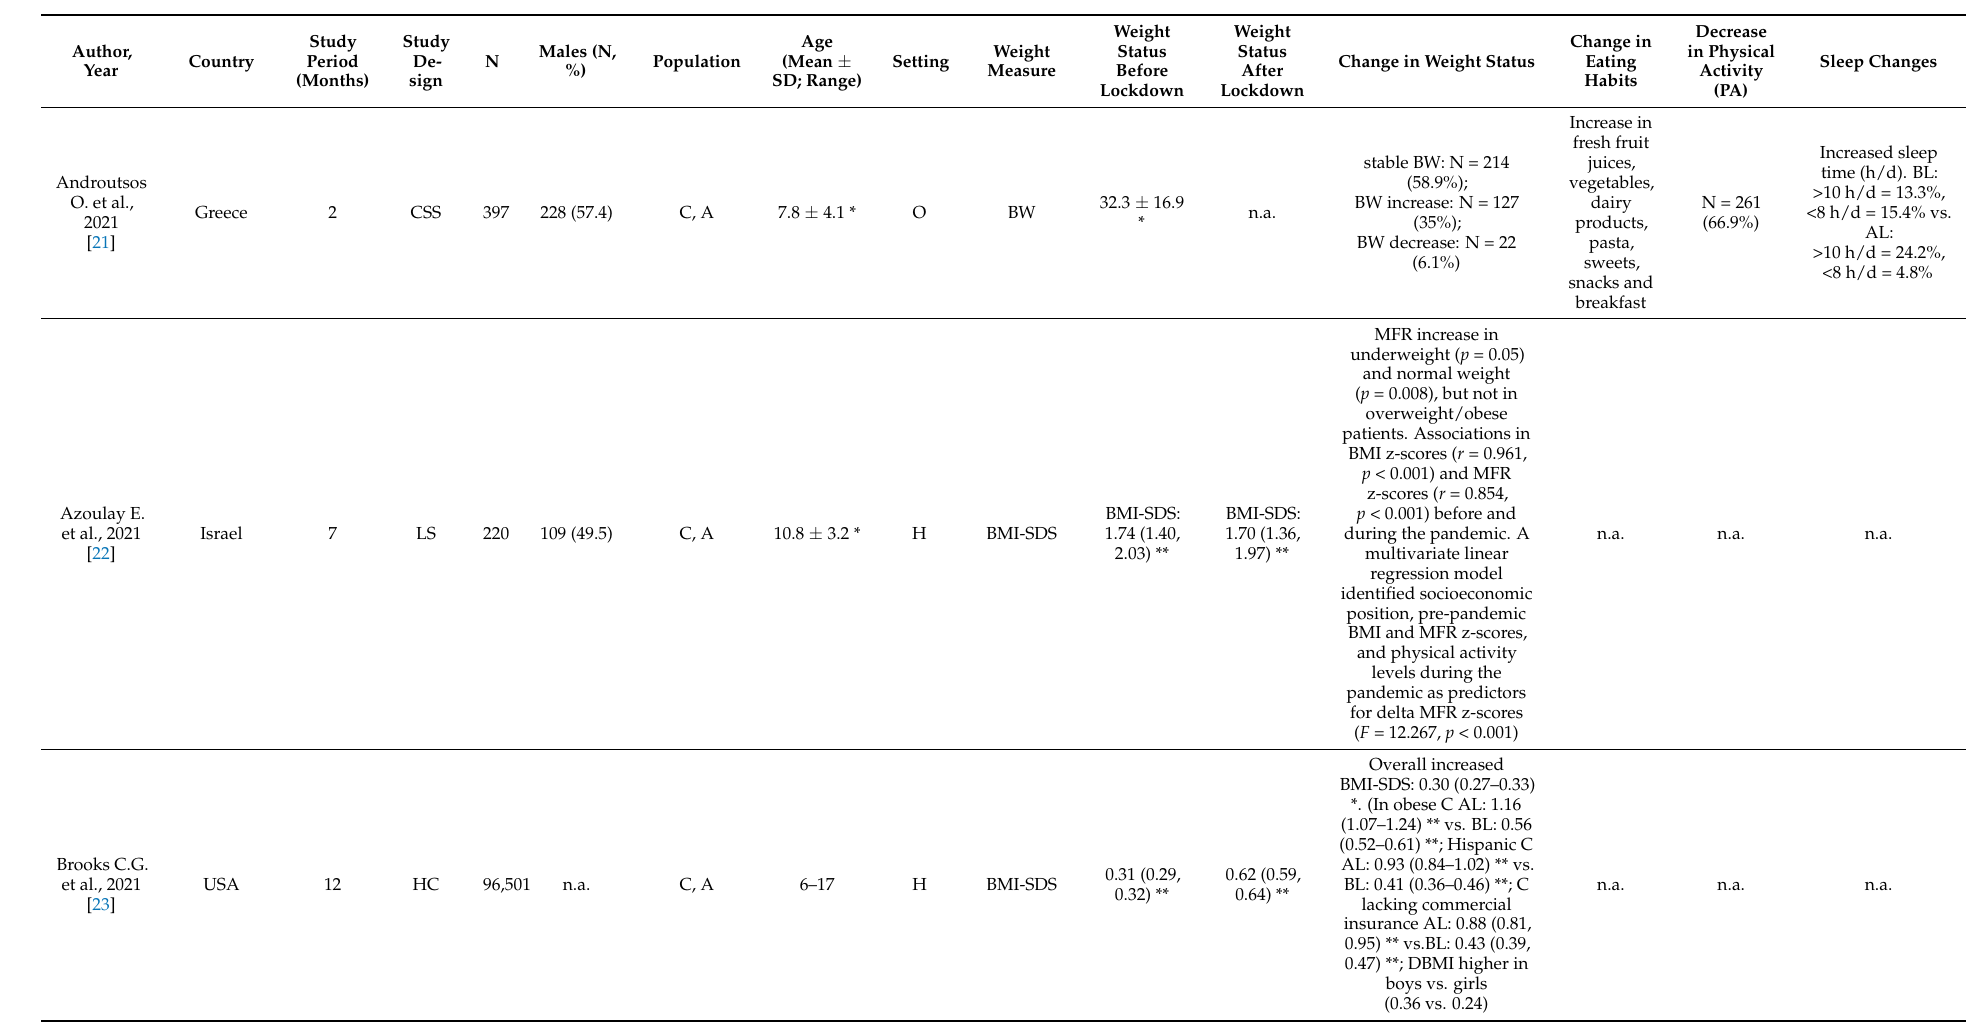
Table 1. Main patient and protocol features of studies assessing the impact of COVID-19 lockdown on weight and lifestyle changes included in the literature